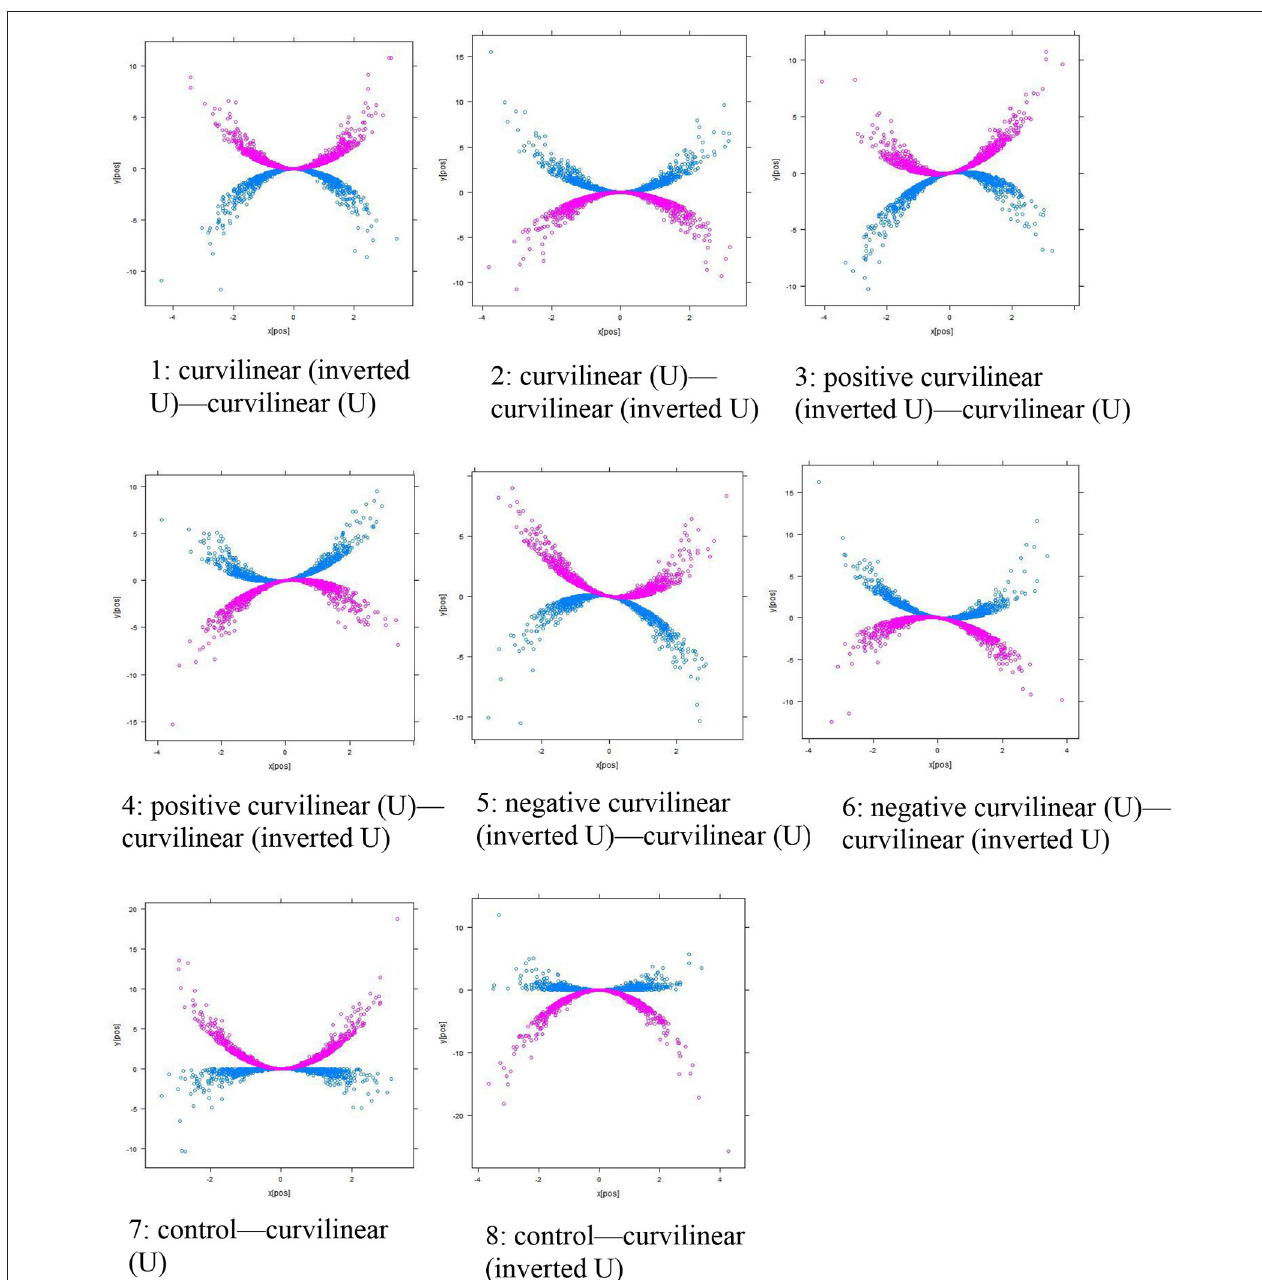
FIGURE 3 | Eight types of Curvilinear Moderations (Continuous). The blue line shows the group of observations with a lower score in the moderator M (i.e., 1 SD below mean in continuous moderation). The purple line shows the group of observations with a higher score in the moderator M (i.e., 1 SD above mean in continuous